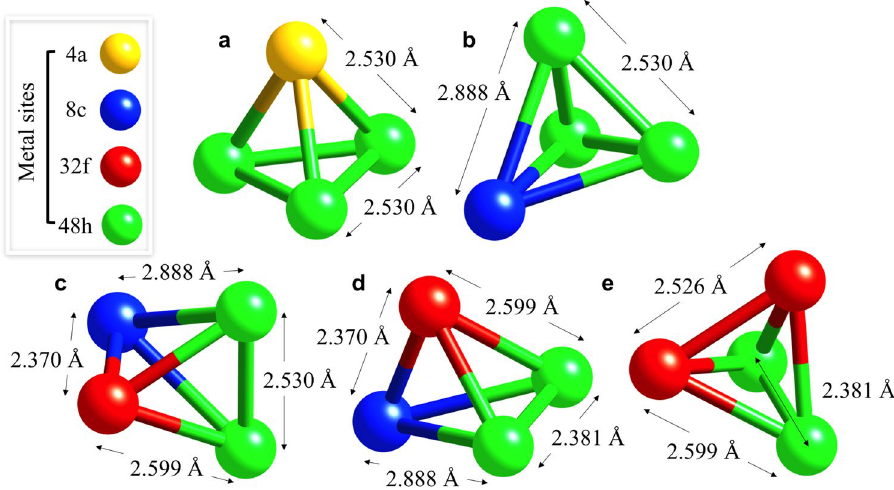
Figure 6. Five 4-site clusters selected for the CEM, namely, ( a ) M (4a) M 3(48h) , ( b ) M (8c) M 3(48h) , ( c ), ( d ) both M (8c) M (32f) M 2(48h) distinguished by their 48h-48h interatomic distance, and ( e ) M 2(32f) M 2(48h) . The interatomic distances are those obtained for Cr 23 C 6 with a 0 = 10.524